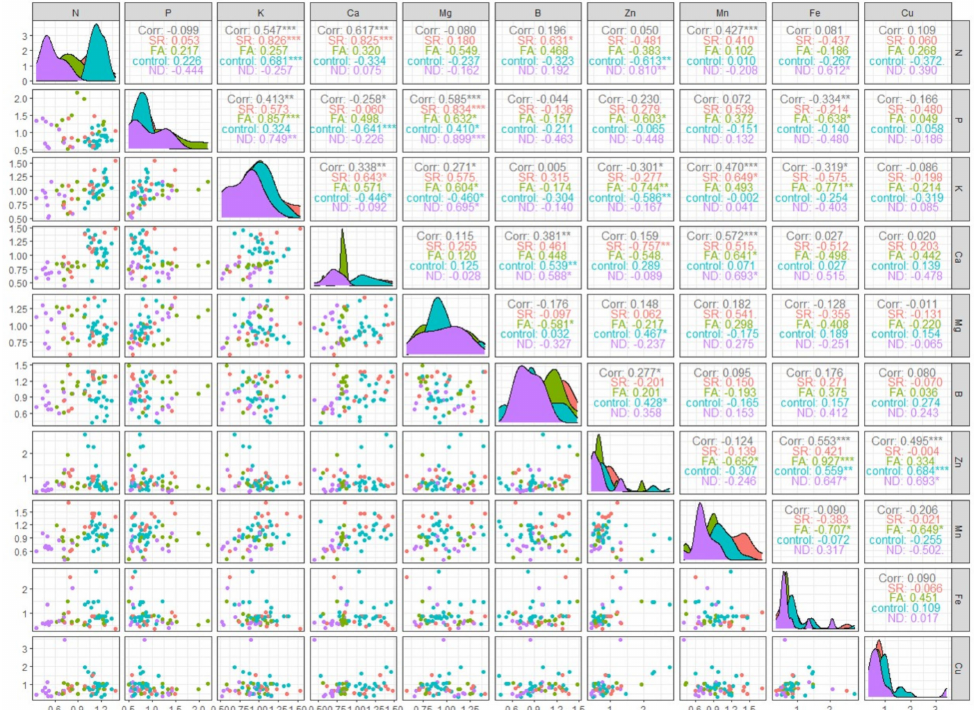
Figure 5. Matrices of Pearson correlation coefficients for the correlations between mineral nutrient contents in the leaves and N contents. In the boxes over the diagonal line, the values of correlation and the significance levels as asterisk were presented. Each significance level is associated with the number of asterisk: *, **, ***; significant at p < 0.05, 0.01, 0.001 respectively. The color of the text in the boxes indicates each treatment: orange for SR, green for FA, skyblue for control and purple for ND